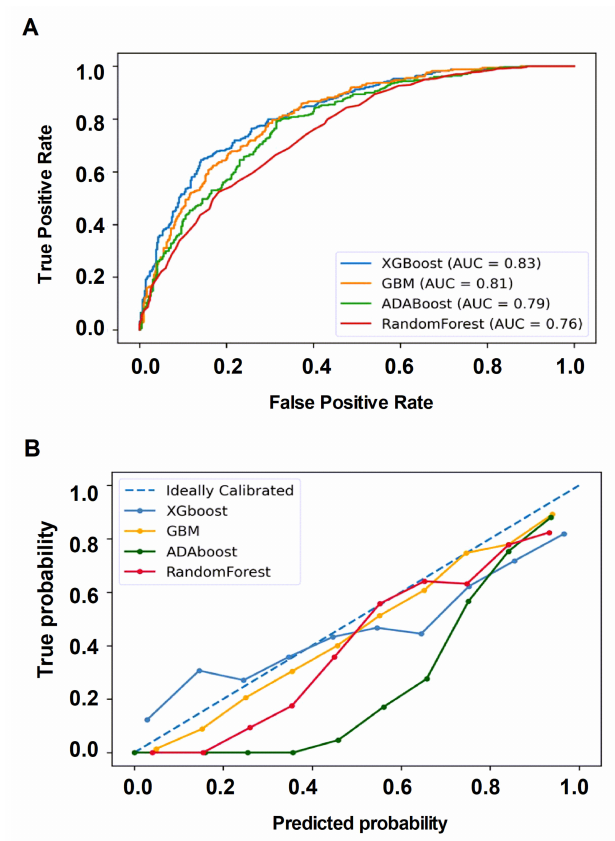
Figure 2. ( A ). The receiver operating characteristic curve was used to illustrate the performance of classifiers at various threshold settings, and AUC represents the degree of performance ( B ). The calibration curve was a reliability diagram to show the relative frequency of observed versus the predicted probability. Abbreviations: XGBoost, eXtreme Gradient Boosting; GBM, Gradient Boosting Machine; AdaBoost, Adaptive Boosting; RF, Random